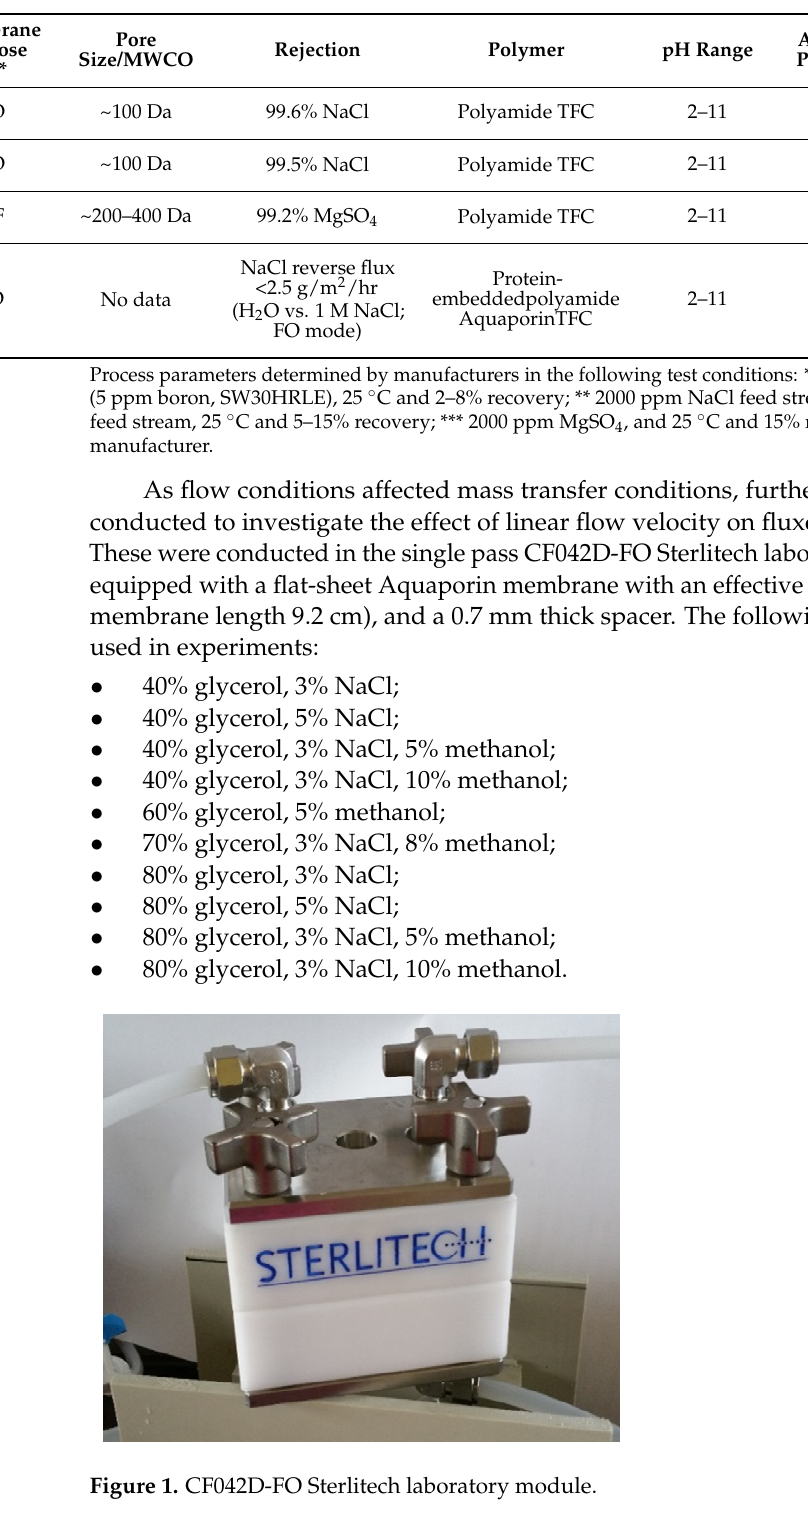
Table 1. Characteristics of the membranes tested.